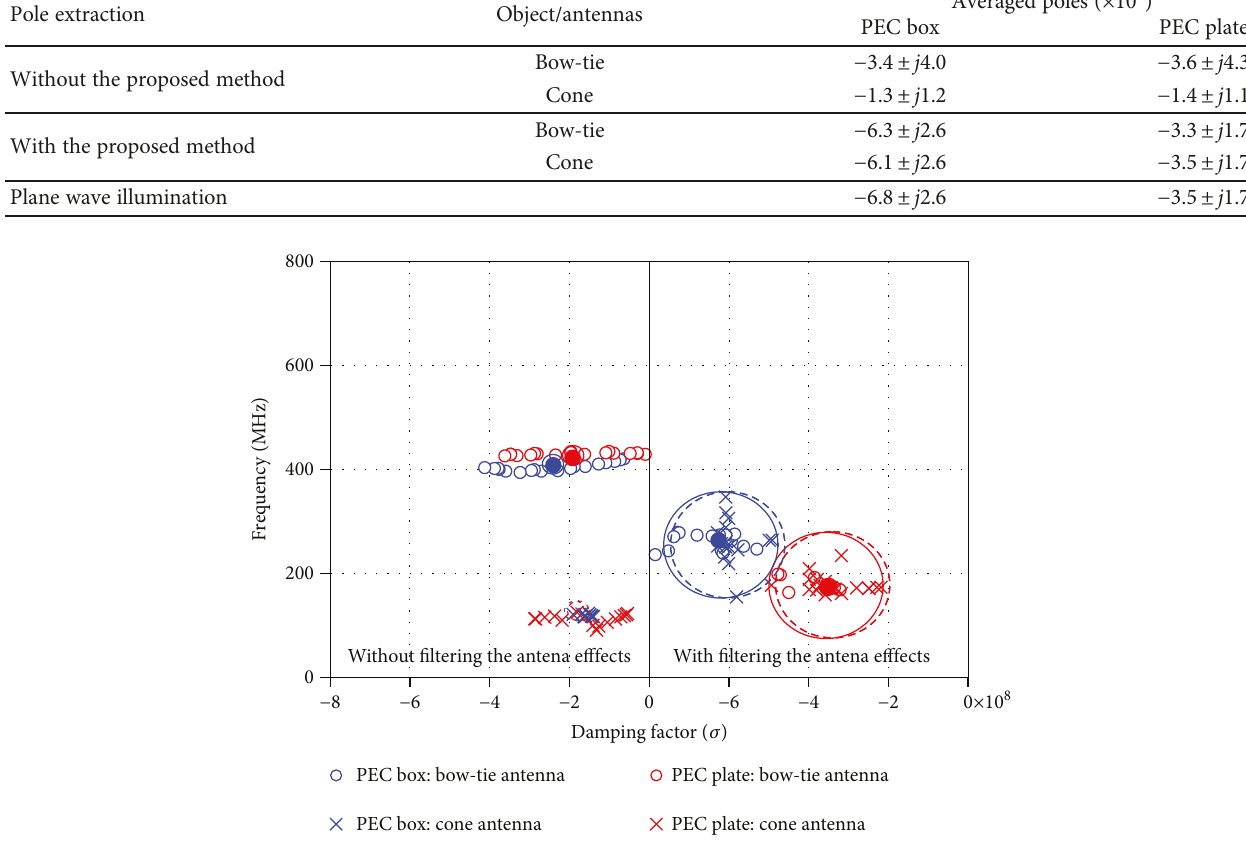
Figure 5: Selected poles of simulations for target classi fi cation.